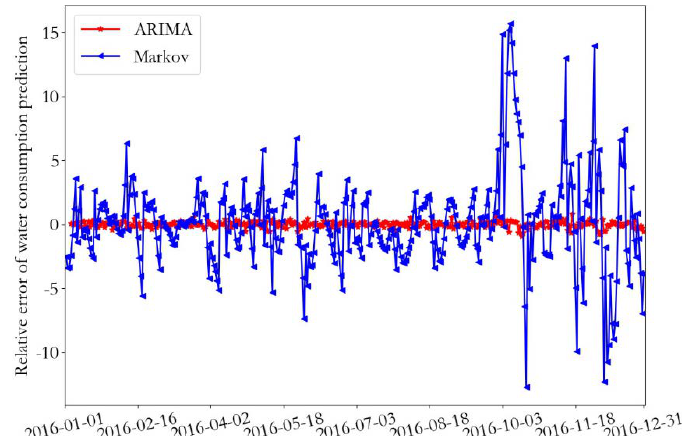
Figure 12. Prediction results from the training data at monitoring point 1.